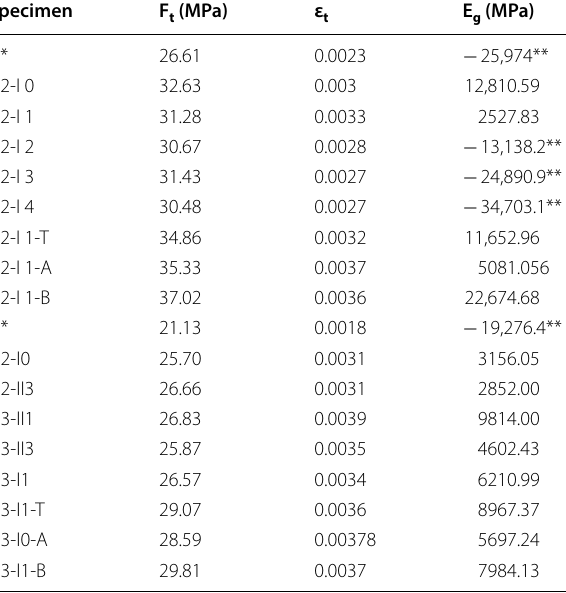
Table 7 Summary of the testing